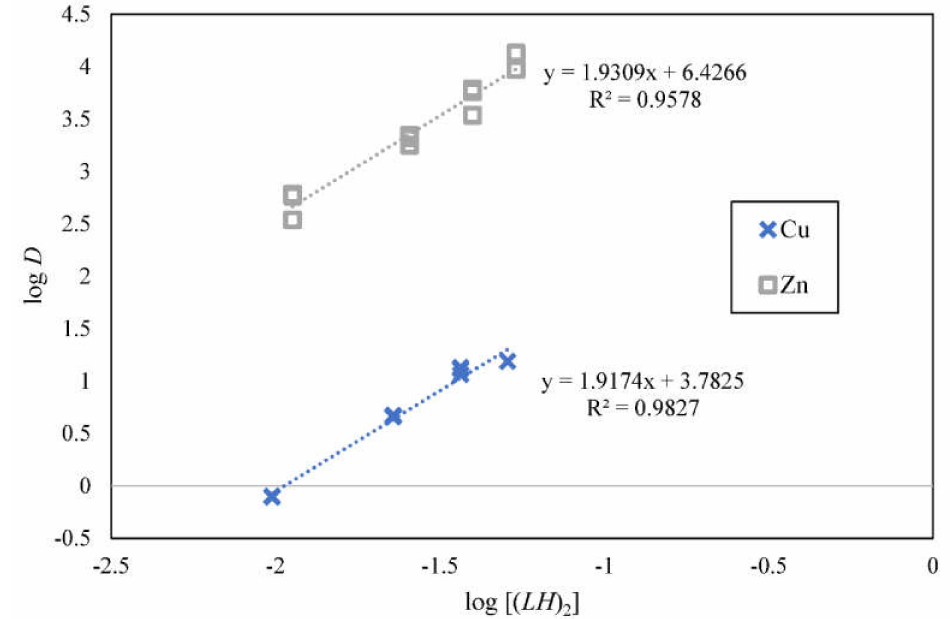
Figure A1. Value of x for both copper and zinc were found to be ≈